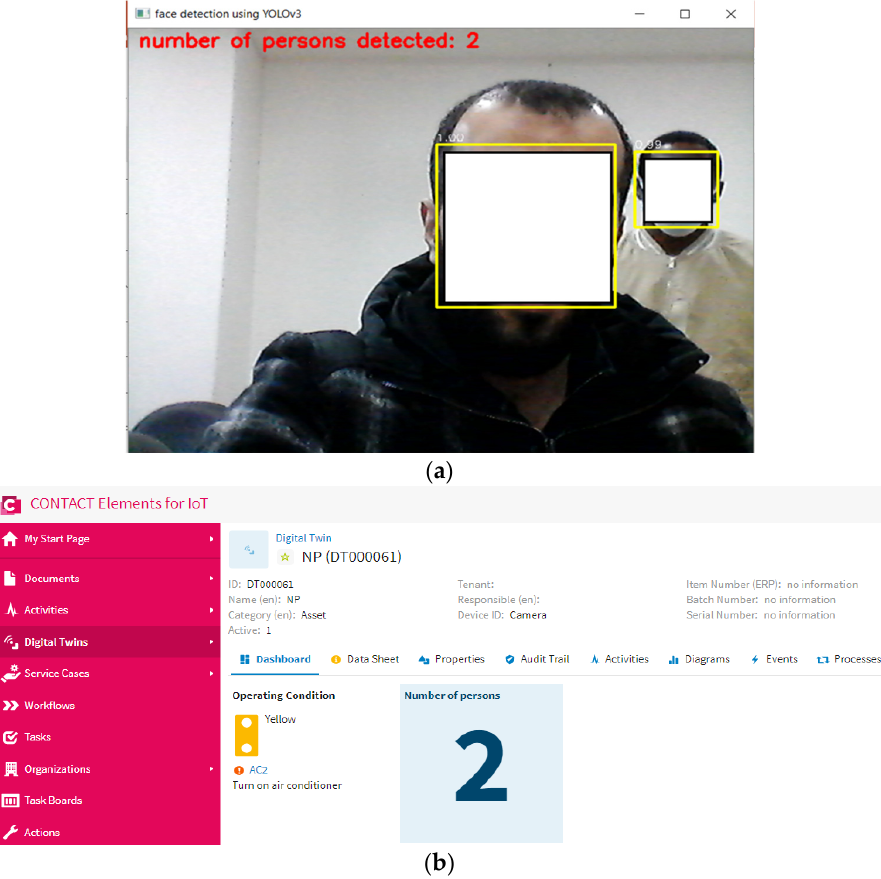
Figure 12. The number of persons detected—in this case, 2 persons: ( a ) the output of YOLOv3 algorithm, ( b ) the presented output on the dashboard of the IoT platform.